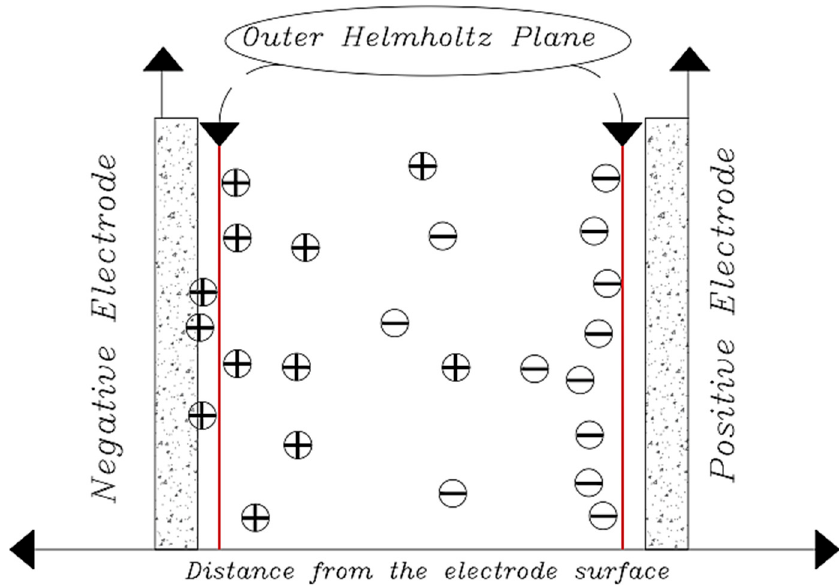
Figure 13. Load distribution in a system with charged electrodes.